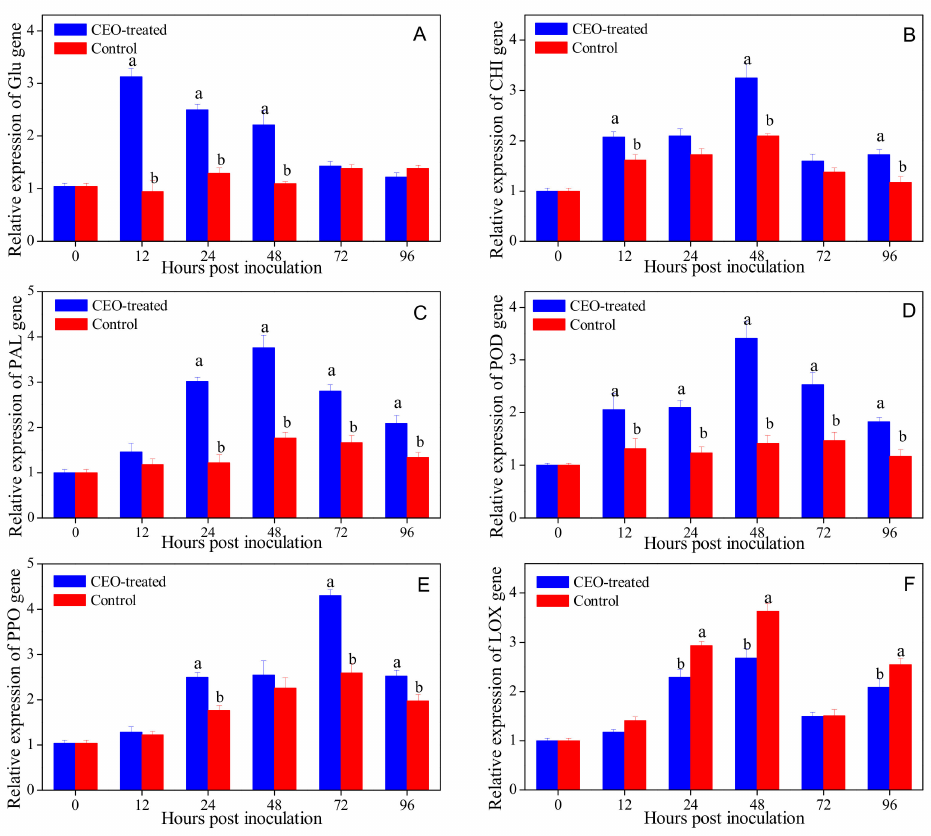
Figure 4. Relative expression of β -Glu ( A ), CHI ( B ), PAL ( C ), POD ( D ), PPO ( E ) and LOX ( F ) genes in citrus fruit treated with CEO (0.4%, v / v ) infected with P. italicum , and incubated at 25 ◦ C for 96 h. Each value represents the mean of three replicates ± standard error (S.E.). Di ff erent lowercase letters indicate significant di ff erences ( p < 0.05) between CEO-treated and control group at the same time by Tukey HSD